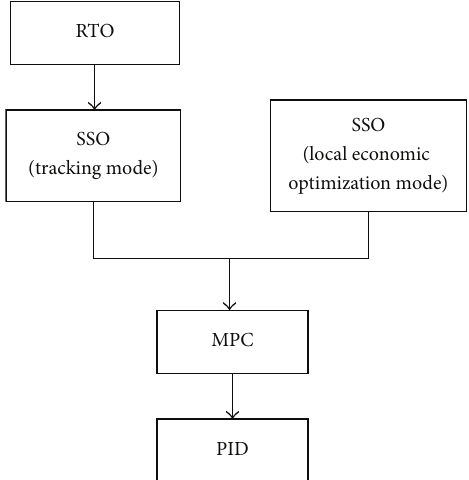
Figure 2: Framework of two-layer predictive control of industrial